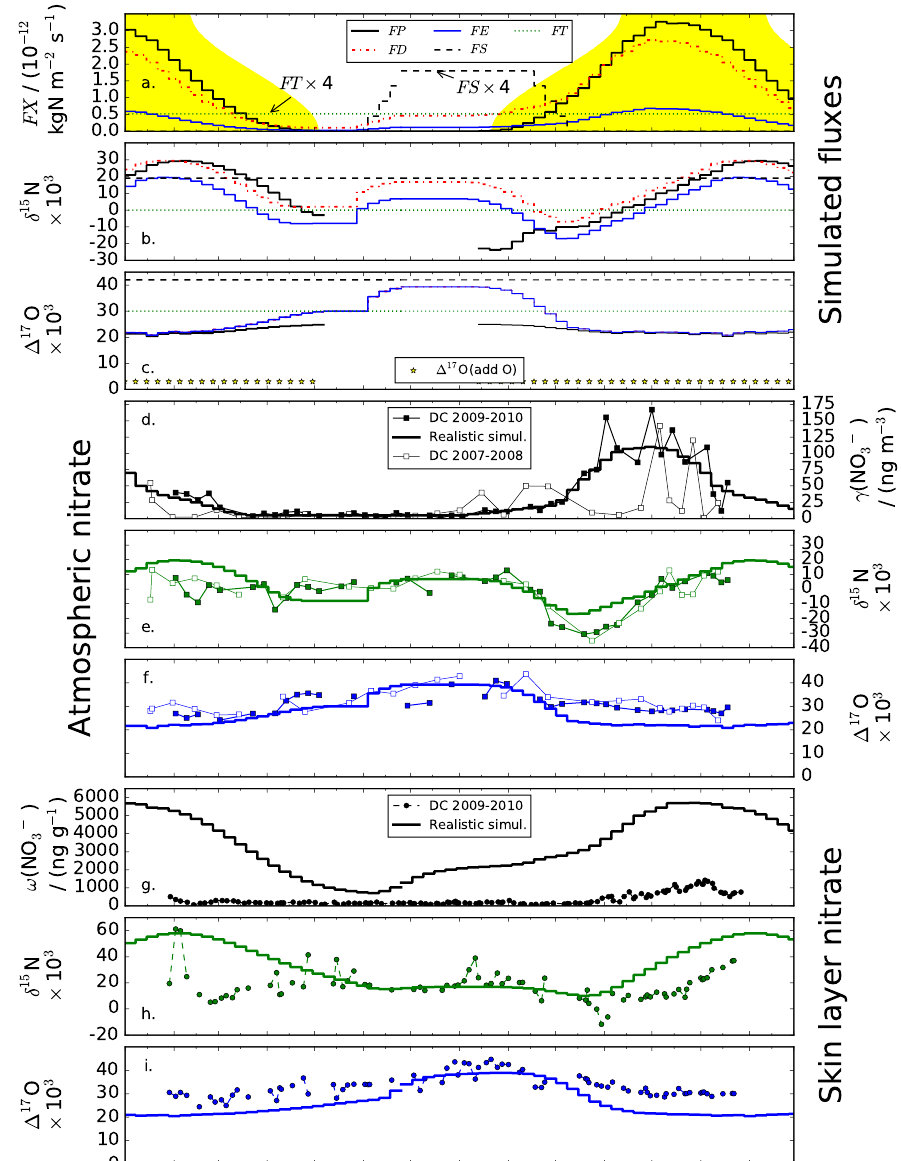
Figure 4. Realistic simulation results and comparison to the observations at Dome C. (a–c) Simulated fluxes (mass and isotopic composition) and (cid:49) 17 O in the additional O atom (panel c ). The legend in panel (a) also applies to panels (b) and (c) . The yellow areas in panel (a) represent the day length at Dome C. Note that δ 15 N and (cid:49) 17 O in FE and FD are equal. (d–f) Simulated and observed concentrations, δ 15 N and (cid:49) 17 O in atmospheric nitrate. (g–i) Simulated and observed mass fractions, δ 15 N and (cid:49) 17 O in skin layer nitrate. The 2007–2008 and 2009–2010 observed data originate from Frey et al. (2009) and Erbland et al. (2013),